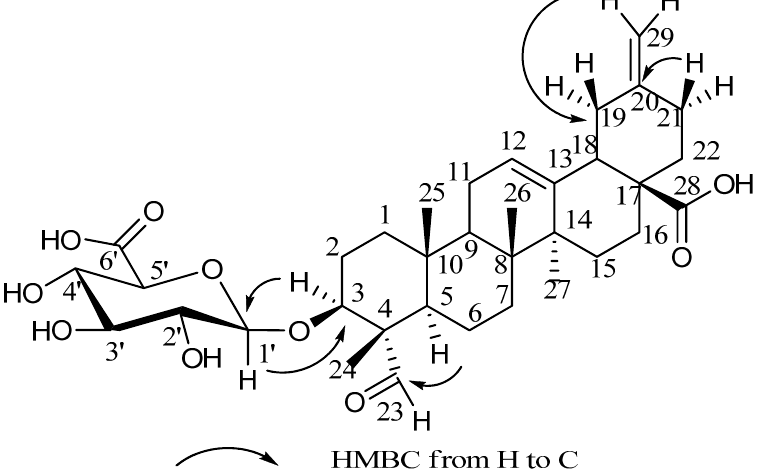
Figure 2. Key HMBC correlations for compounds 11 .